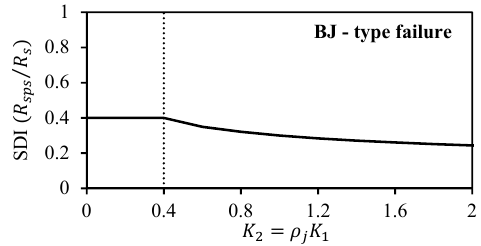
Figure 19. SD index corresponding to BJ-Failure Figure 18. SD index corresponding to J-Failure. Figure 18. SD index corresponding to J-Failure